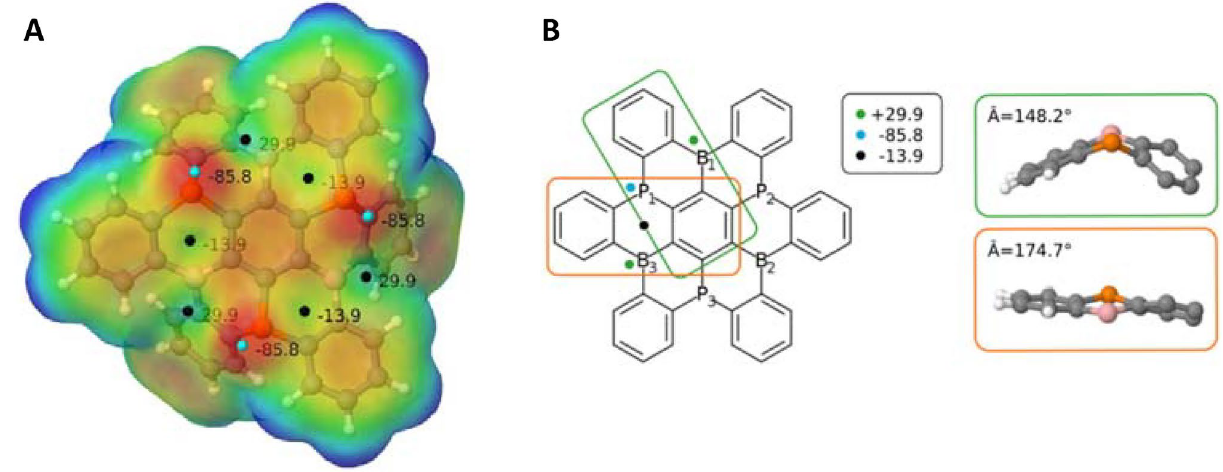
Figure 3. ( A ) MEP of the + z face of monomer B 3 P 3 -NG on the 0.001 a.u. electronic density isosurface. Cyan small points indicate the minima of the MEP, and black points the corresponding maxima. The MEP values are given in kJ mol –1 , the color range used is [− 79.0; + 66.0] kJ mol −1 ,